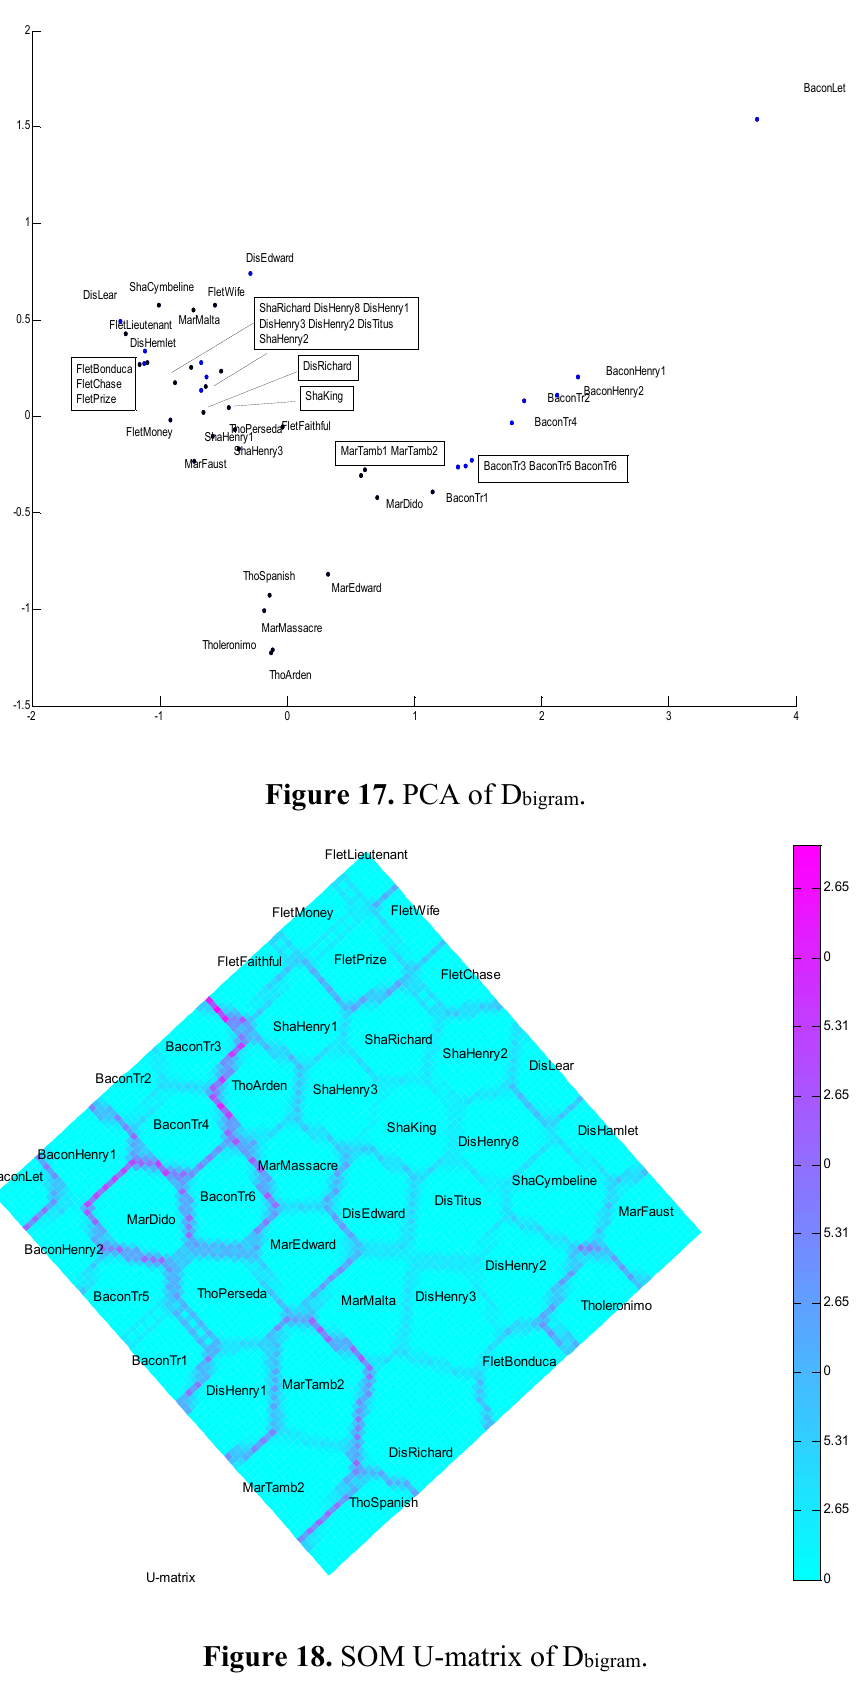
Figure 18. SOM U-matrix of D bigram